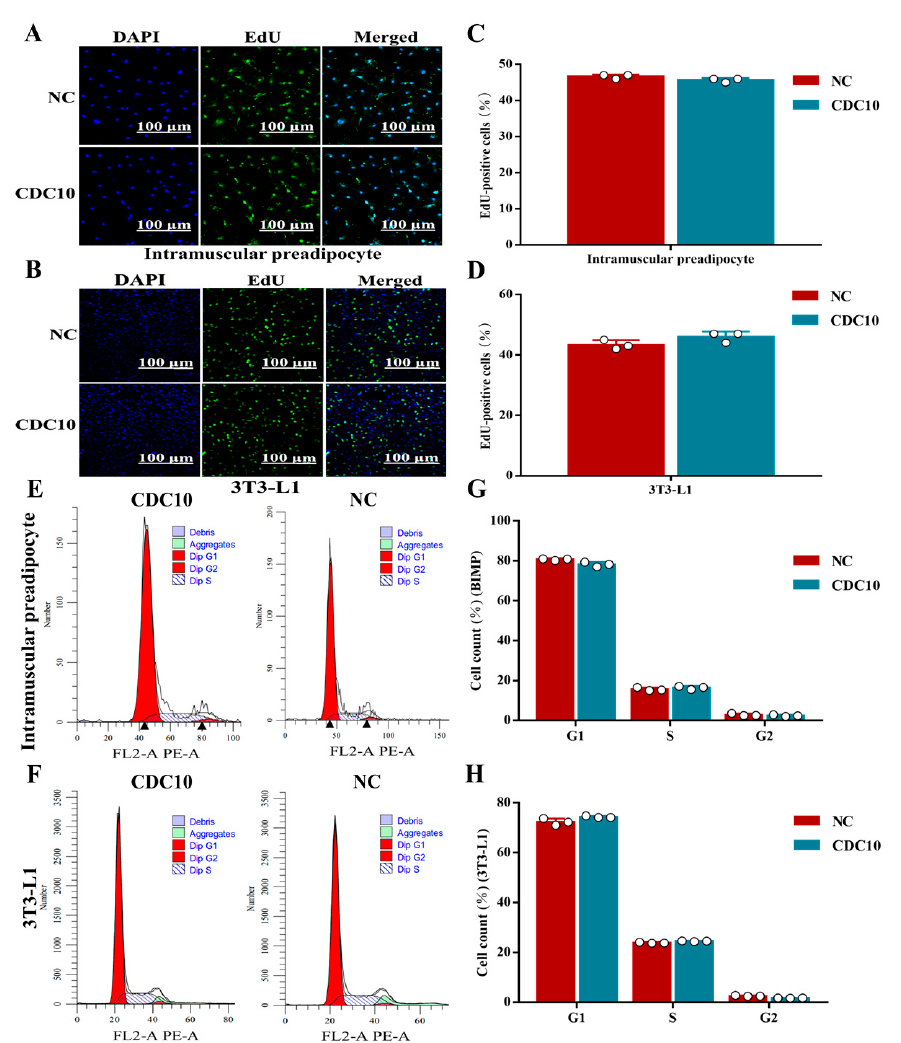
Figure 6. The effect of CDC10 overexpression on the proliferation of bovine intramuscular preadipocyte (BIMP) and 3T3-L1 cells was detected by EdU and flow cytometry assay. BIMP and 3T3-L1 cells were transfected with lentivirus for 96 h during proliferation. ( A , B ) The proliferations of BIMP and 3T3-L1 cells were examined by EdU immunofluorescent staining. Green color represents EdU staining and blue color represents cell nuclei stained with Hoechst 33342. ( C , D ) The percentage of EdU-positive cells were quantified. ( E – H ) Cell cycle phase analysis of BIMP and 3T3-L1 cells by flow cytometry and their statistical results. Values are expressed as mean ± SEM ( n = 3). 3.6. Overexpression of CDC10 Promotes Differentiation of BIMP and 3T3-L1 Cells Oil Red O staining revealed that overexpression of CDC10 led to significantly increased lipid droplets produced by BIMP and 3T3-L1 cells compared with the control groups (Figure 9A,B). The results of Oil Red O extraction showed that overexpression of CDC10 led to increases in the intracellular lipid content of BIMP and 3T3-L1 cells compared with the control group ( p < 0.01) (Figure 9C,D). RT-PCR results showed that the expression of CDC10 was significantly higher than that of the control group ( p < 0.01) (Figure 10A,B). The levels of adipogenic marker genes PPAR γ , C/EBP α , FABP4 , and FASN were significantly increased in BIMPs at the mRNA level following overexpression of CDC10 ( p < 0.05, p <0.01, p < 0.01, and p < 0.01, respectively) (Figure 10A), while PPAR γ , C/EBP α , and FABP4 were significantly increased in 3T3-L1 at the mRNA level following overexpression of CDC10 ( p < 0.01, p < 0.05, and p < 0.01, respectively) (Figure 10B). However, expression of ATGL was decreased in BIMP ( p < 0.01) and 3T3-L1 cells ( p < 0.05) after overexpression